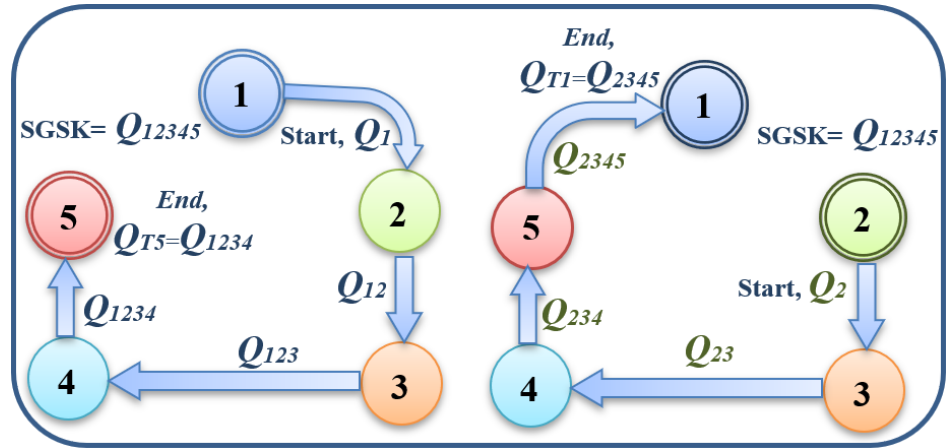
Figure 3. Shared group secret